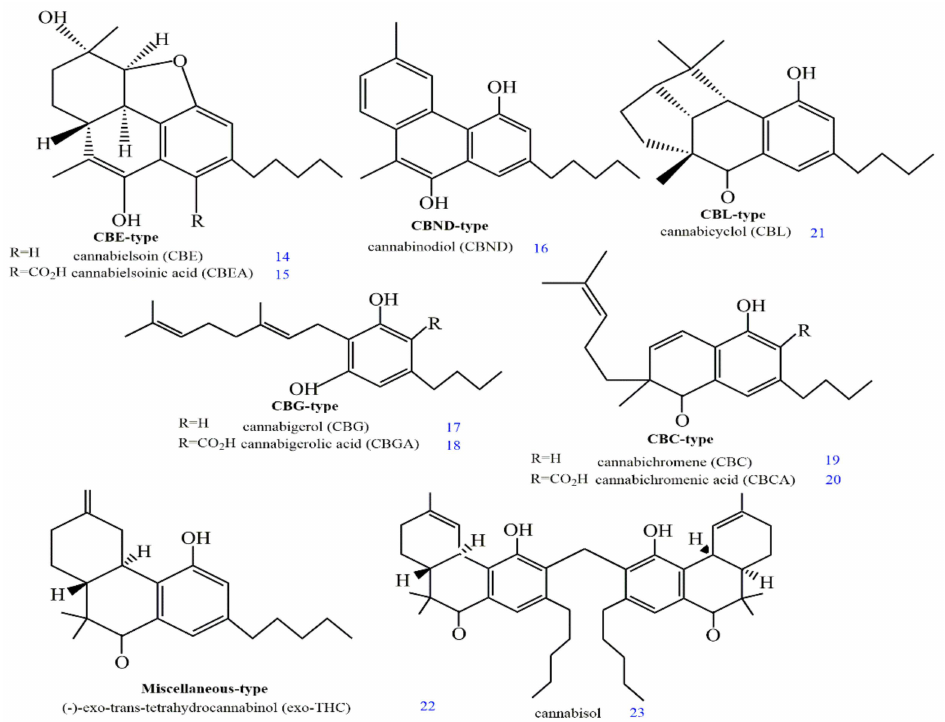
Figure 1. The structures of various phytocannabinoids derived from C. sativa (created with Chem- Draw